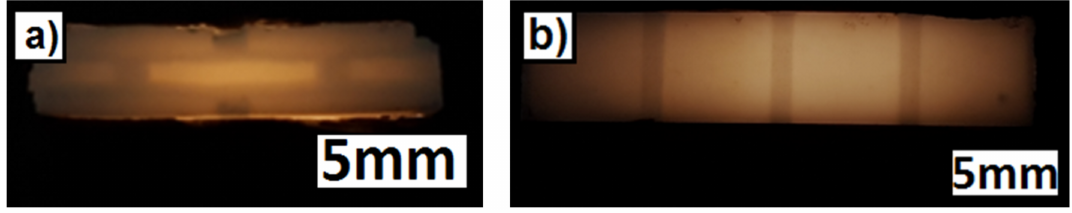
Figure 22. Sintered zirconia 4D component in front of a light spot with two different microstructures (darker areas: porous; brighter areas: dense); ( a ) side view (section); ( b ) top